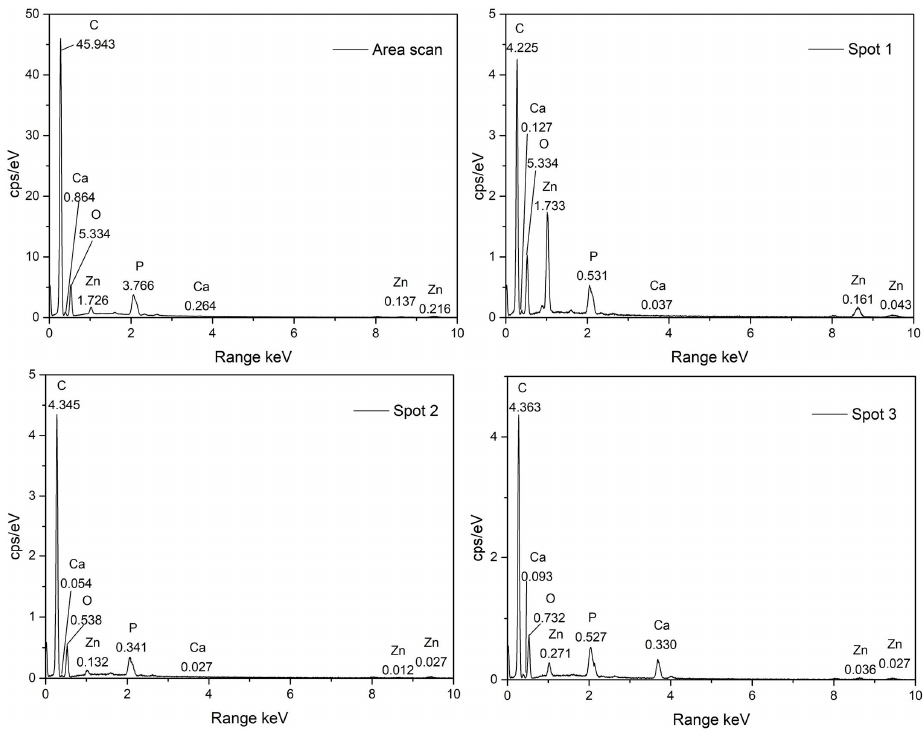
Figure 9. EDS analysis of area scan and three selected spots in Figure 7. Table 2. EDS analysis results of the area scan and three selected spots shown in Figure 9.